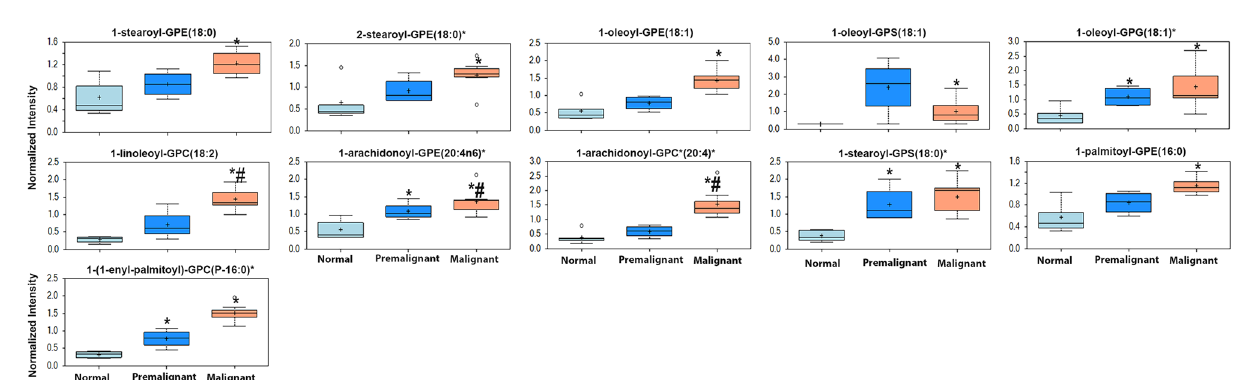
Figure 3. Upregulation of phospholipid and lysophospholipid metabolites: the expression of glycerphosphoethanolamine (GPE), glycerphosphocholine (GPC), glycerophosphoserine (GPS), glycerophosphoglycerol (GPG) and lysophospholipids in normal, premalignant, and early malignant bladder lesions. * p < 0.05 compared to normal bladders (n = 5). # p < 0.05 comparing premalignant lesions (n = 4) to early malignant/NMIBC (n = 7); one-way ANOVA with multiple